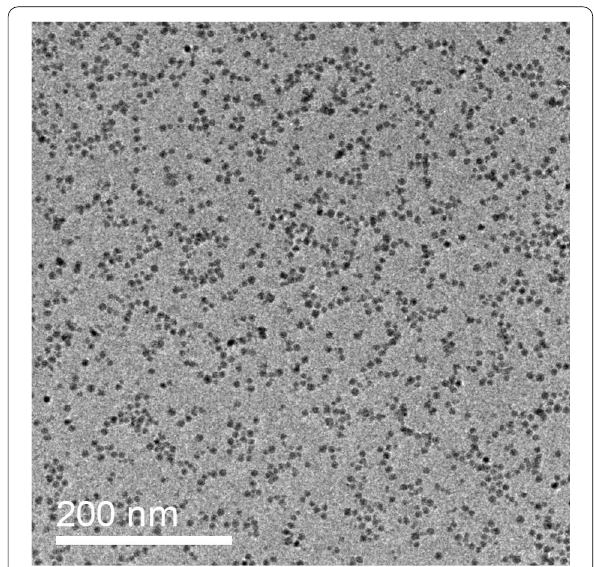
Fig. 4 TEM image of Fe nanoparticle arrays deposited on a Formvar film with a deposition rate of 0.1 Å ∙s −